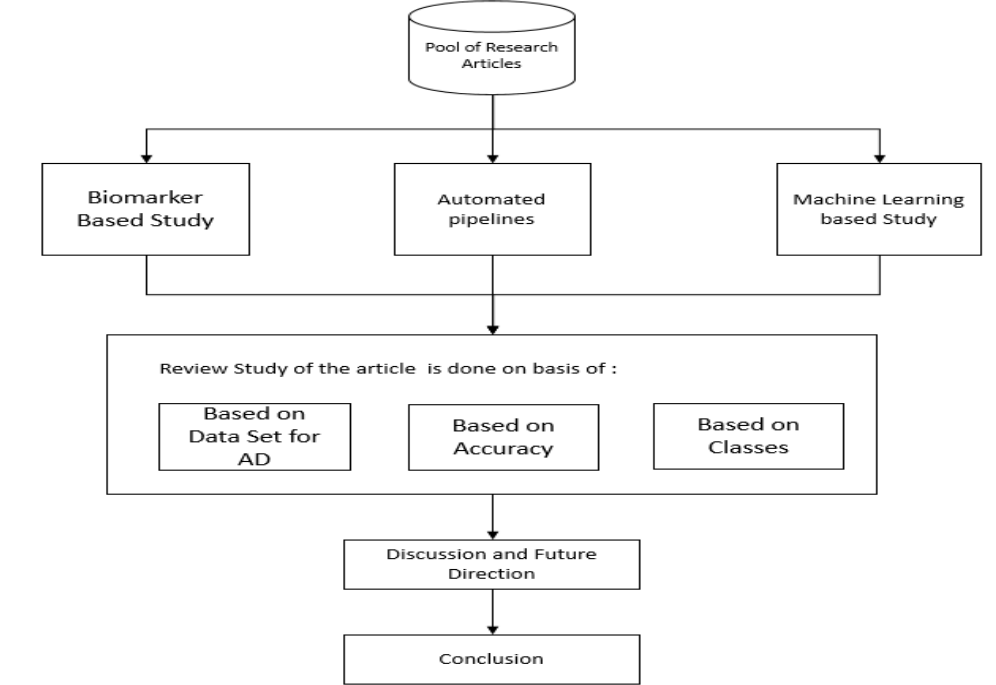
Figure 1. Review Figure 1. Review Methodologies.